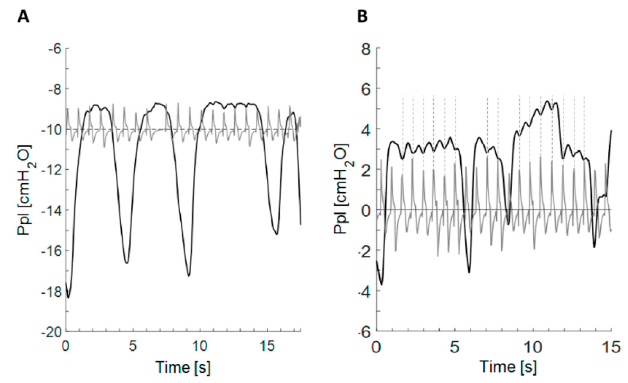
Figure 3. Comparison of pleural pressure curve pulsation with pulse rate recorded by self-developed device. ( A ) Simultaneous record of pleural pressure and pulse curve presenting coincidence of peaks of pulse waves with the most negative point of pleural pressure waves; ( B ) Vertical lines were added to document the coincidence of the peak of pulse trace with the most negative point of pleural pressure oscillations seen on the end-expiratory plateau of the pleural pressure curve.